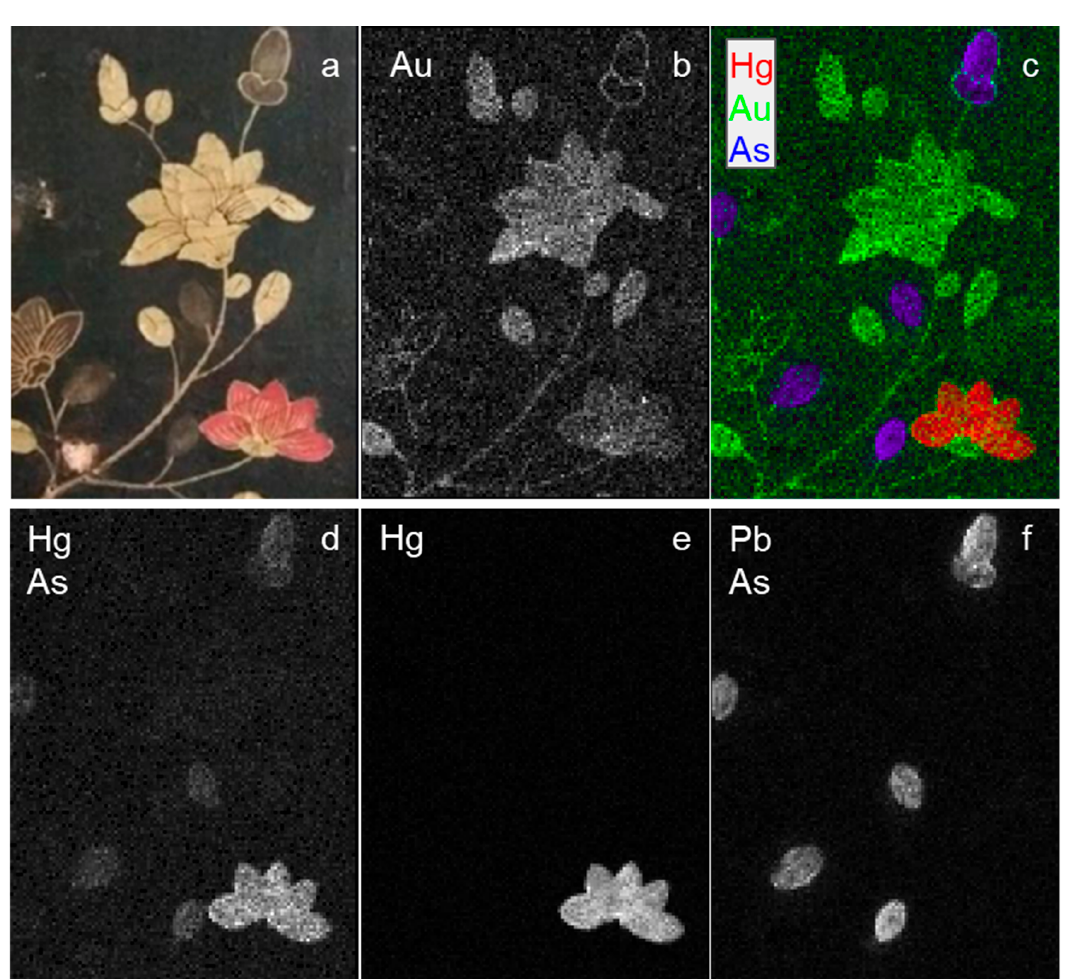
Figure 2. Elemental maps of the first area obtained by the INFN-CHNet MA-XRF scanner. ( a ) Visible. The maps presented are: ( b ) Au; ( c ) RGB map of Hg L α (red), Au L α (green) and As K α (blue); ( d ) Hg L β /As K β transitions; ( e ) Hg L α transition; ( f ) Pb L α /As K α transitions.